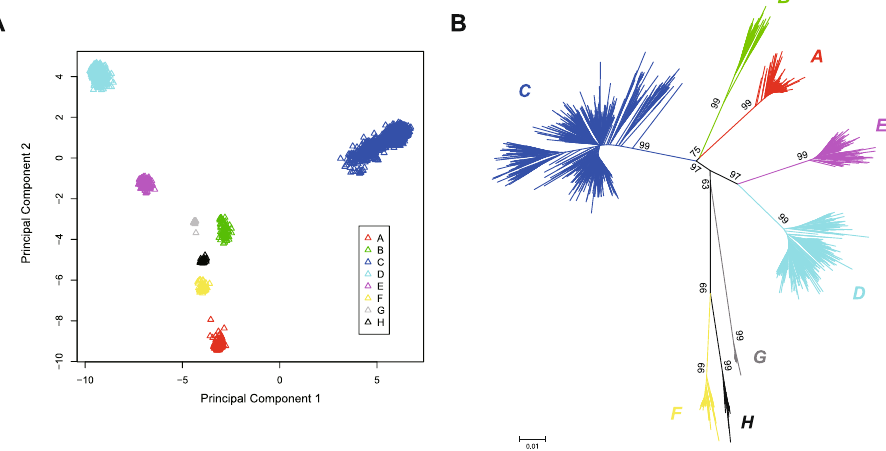
Figure 1. Population structure of 2992 HBV genomes. ( A ) The Principal Component Analysis of 2992 HBV genome sequences, which were labeled in different colors according to their genotypes predicted by fragment typing. ( B ) The unrooted phylogeny tree was computed using Neighbor-Joining method. 100-time bootstrapping test was performed and showed as numbers on clade.